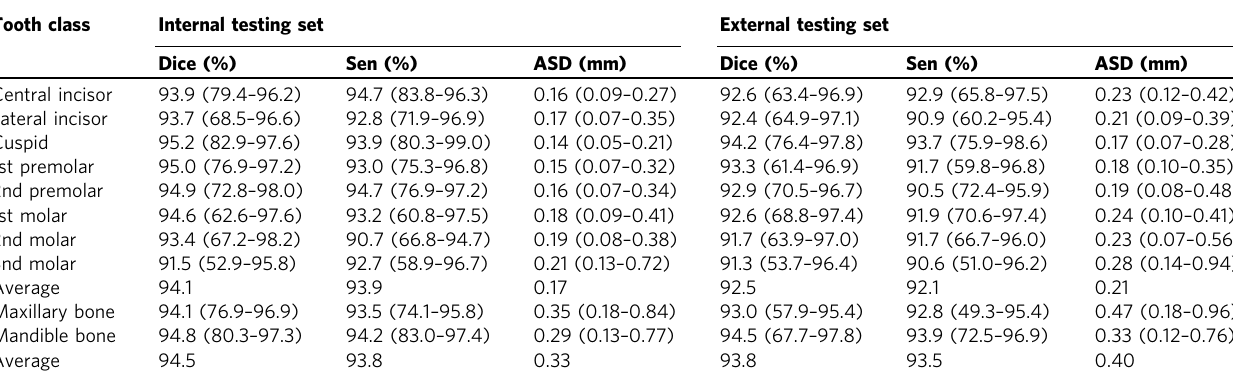
Fig. 2 Overview of our proposed AI system for segmenting individual teeth and alveolar bones from CBCT images. a The input of the system is a 3D CBCT scan. b The morphology-guided network is designed to segment individual teeth. c The cascaded network is used to extract alveolar bones. d The outputs of the model include the masks of individual teeth and alveolar bones. Table 2 Results of the individual teeth and bone segmentation on internal and external testing